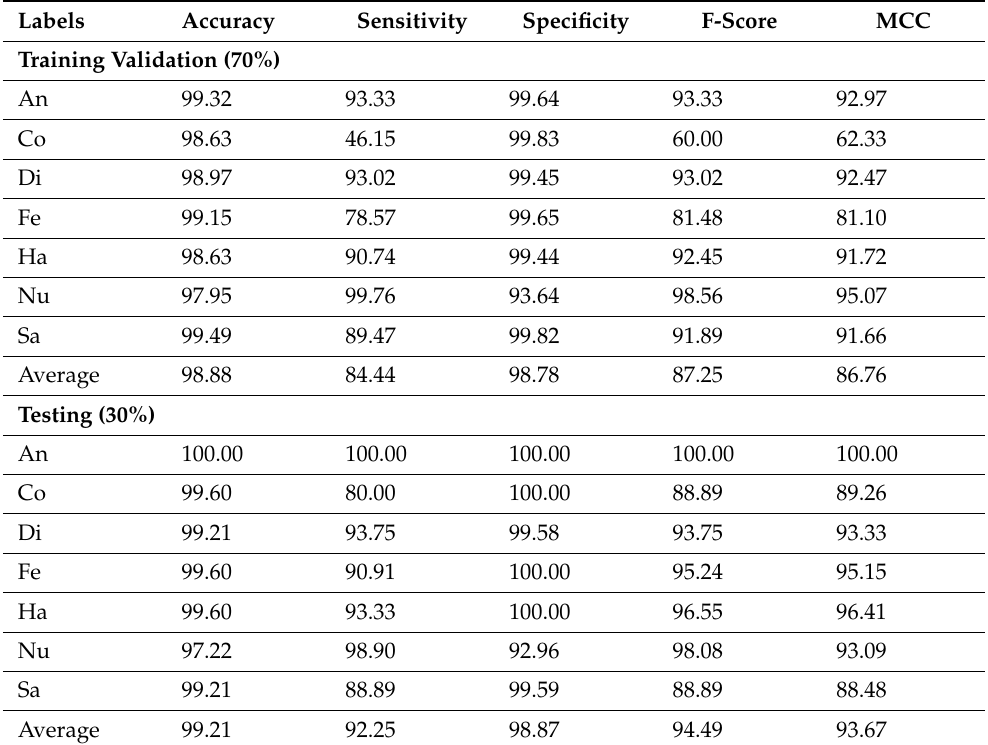
Table 3. RFER-EADL algorithm with different class labels for 70:30 of TR and TS